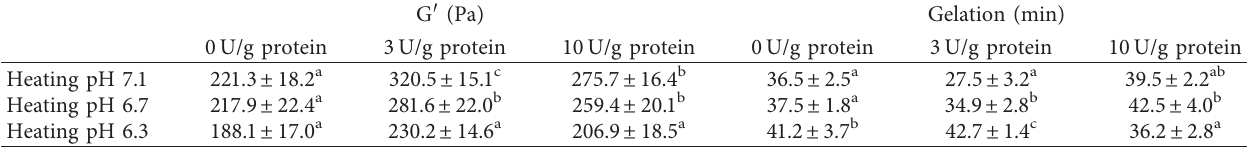
Table 2: Effect of preheating pH and TGase contents on the G ′ and gelation time of acid-induced yak milk gels. G ′ (Pa)